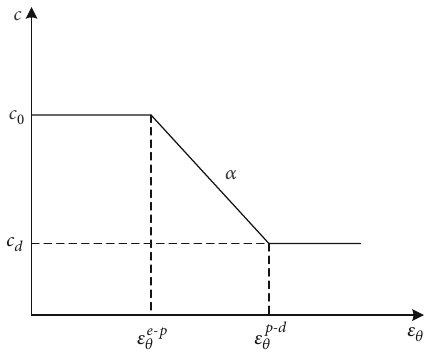
Figure 4: Softening model of the